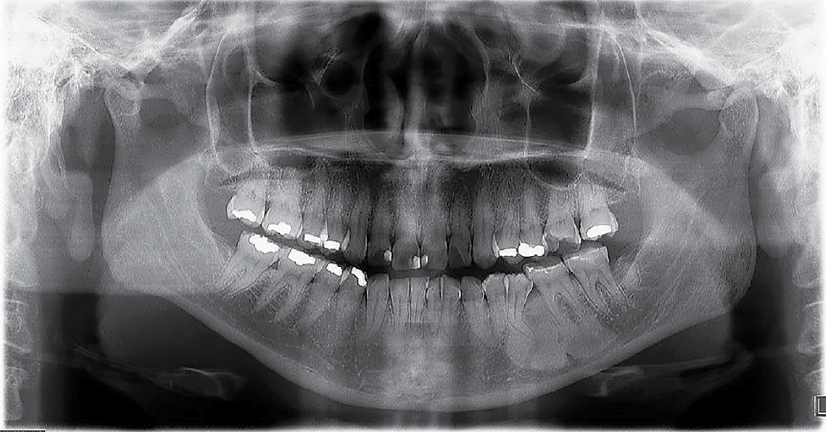
Figure 6- Case 5. A large radiopaque well-defined image is seen in relation with the dilacerated mandibular left second premolar and first molar. A microdontic maxillary left canine is also observed. The small radiopaque mass in the mandibular left third molar area corresponded to a condensing osteitis lesion